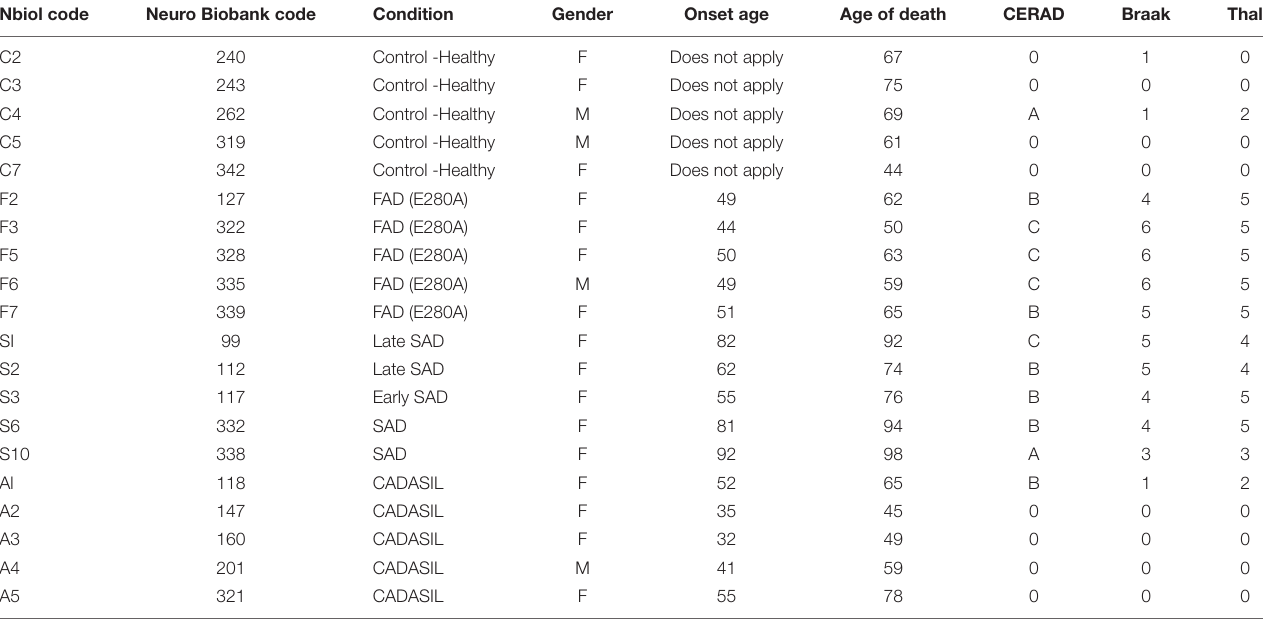
TABLE 1 | Study cases used according to pathological